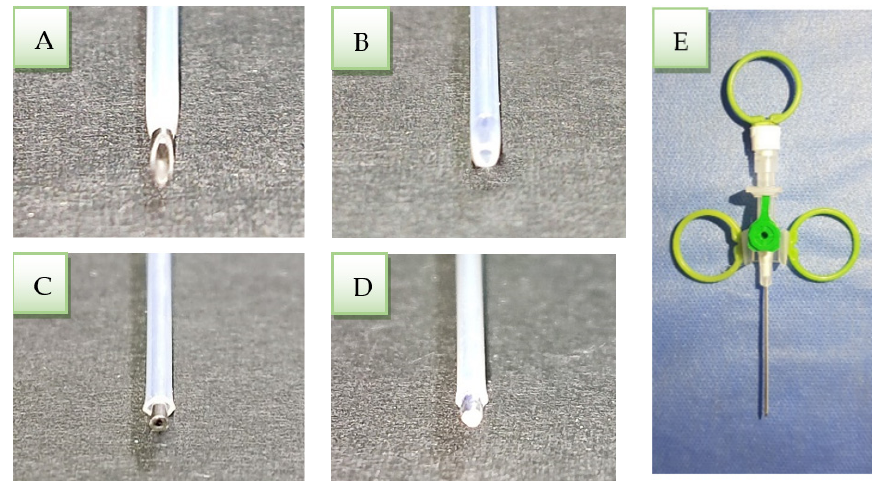
Figure 1. ( A ) The tip of the cannula before modifying. ( B ) The tip of the cannula after cutting the needle. ( C ) The clipped needle after cutting the plastic tube. ( D ) Sealing the clipped needle with silver weld. ( E ) The final shape of the modified cannula. The modified cannula was loaded with the appropriate amount of plug material, delivered into the apical third, injected in small batches, and condensed vertically with the closed needle of the modified cannula. The process was repeated until the apical plug placement was of 4 mm thickness. All procedures were performed by a single specialist. (Figure 2). Finally, all samples were stored in a humid environment for 1 week to ensure that the materials were set.